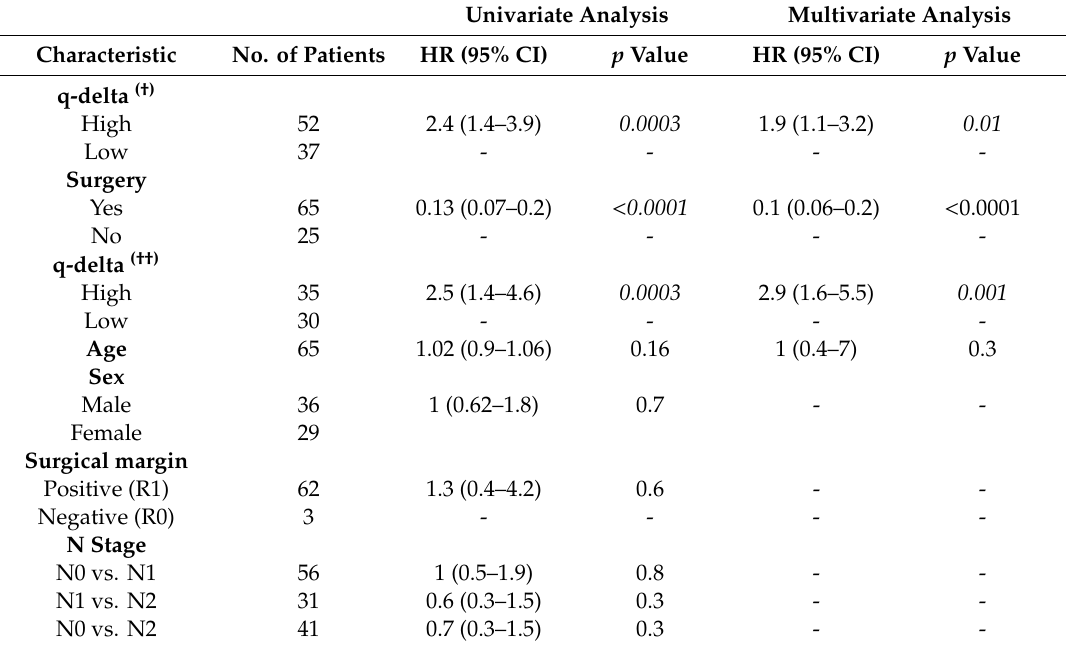
Univariate and multivariate analyses of patients who received gemcitabine-based chemoradiation